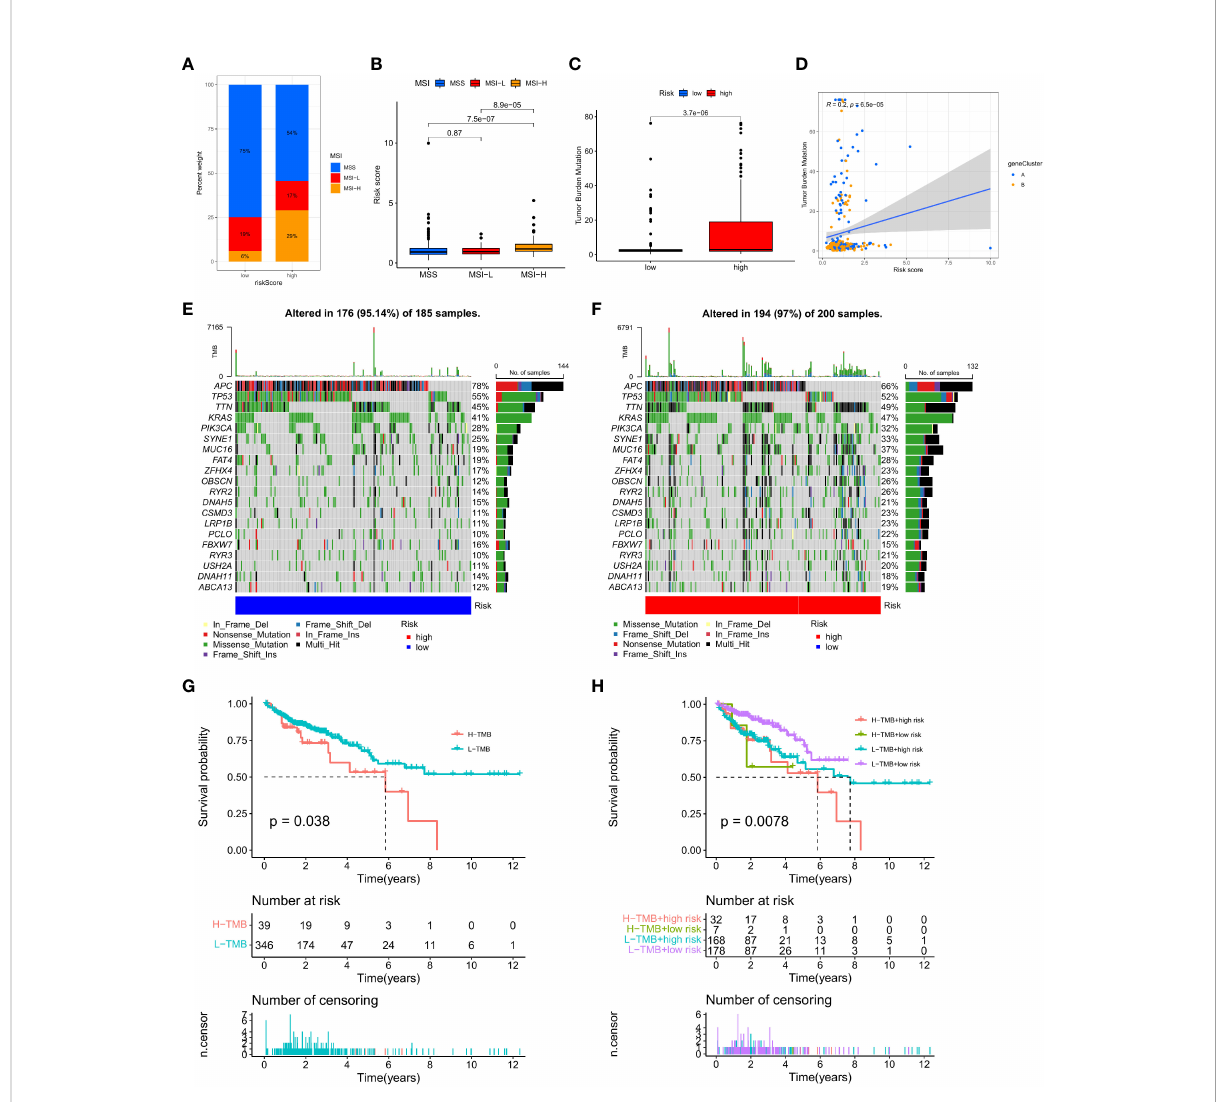
FIGURE 10 Correlation of IMRG risk score with MSI and TMB in COAD patients. (A, B) Relationship between the IMRG risk score and the MSI; (C) Comparison of TMB differences in the high- and low-risk groups; (D) Spearman correlation analysis of IMRG risk score and TMB; (E, F) Oncoplots of somatic mutations established by the IMRG risk score; (G) Prognostic analysis of the TMB; (H) Prognostic analysis between the IMRG risk score and